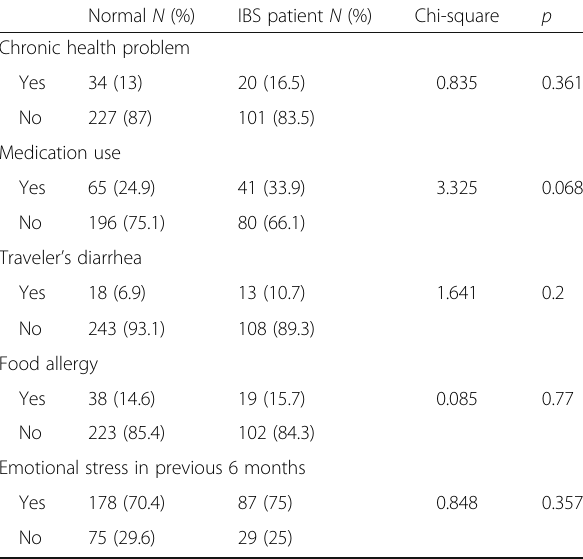
Table 3 Comparison between IBS patients and normal